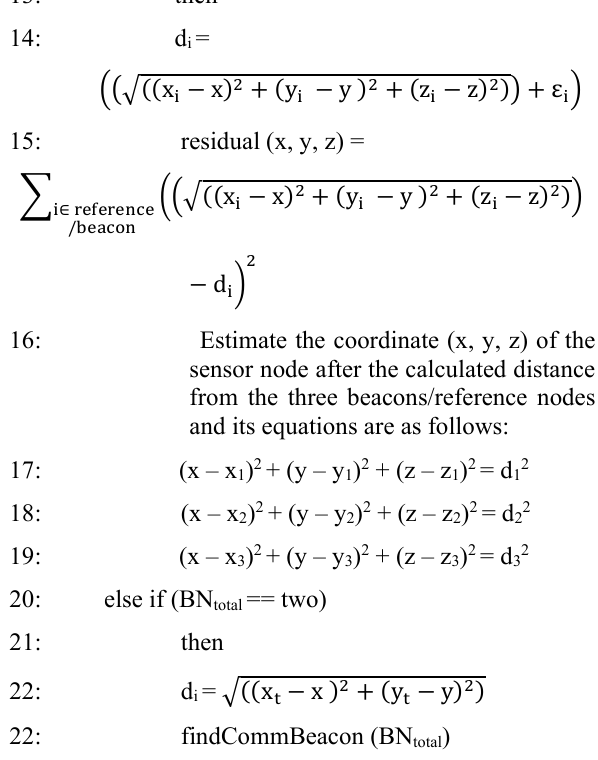
single beacon- based localization